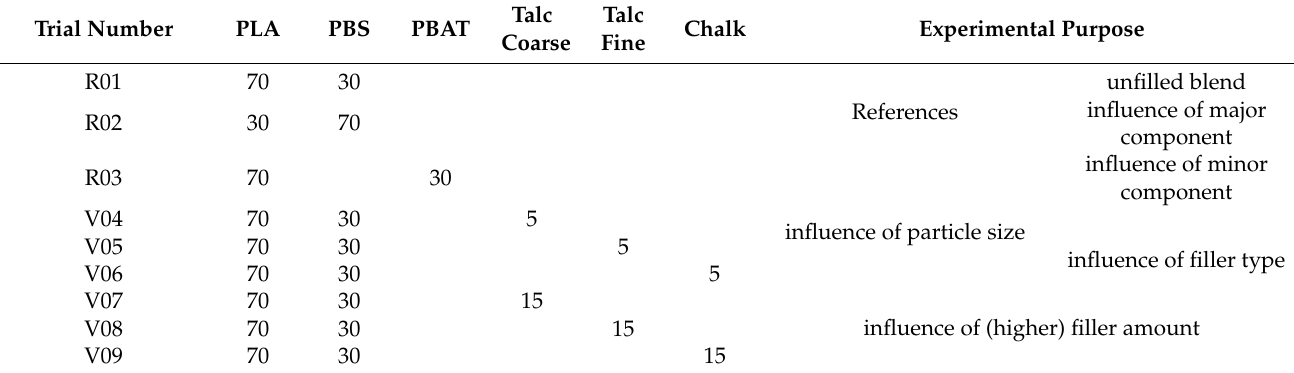
Table 1. Blend formulations and experimental